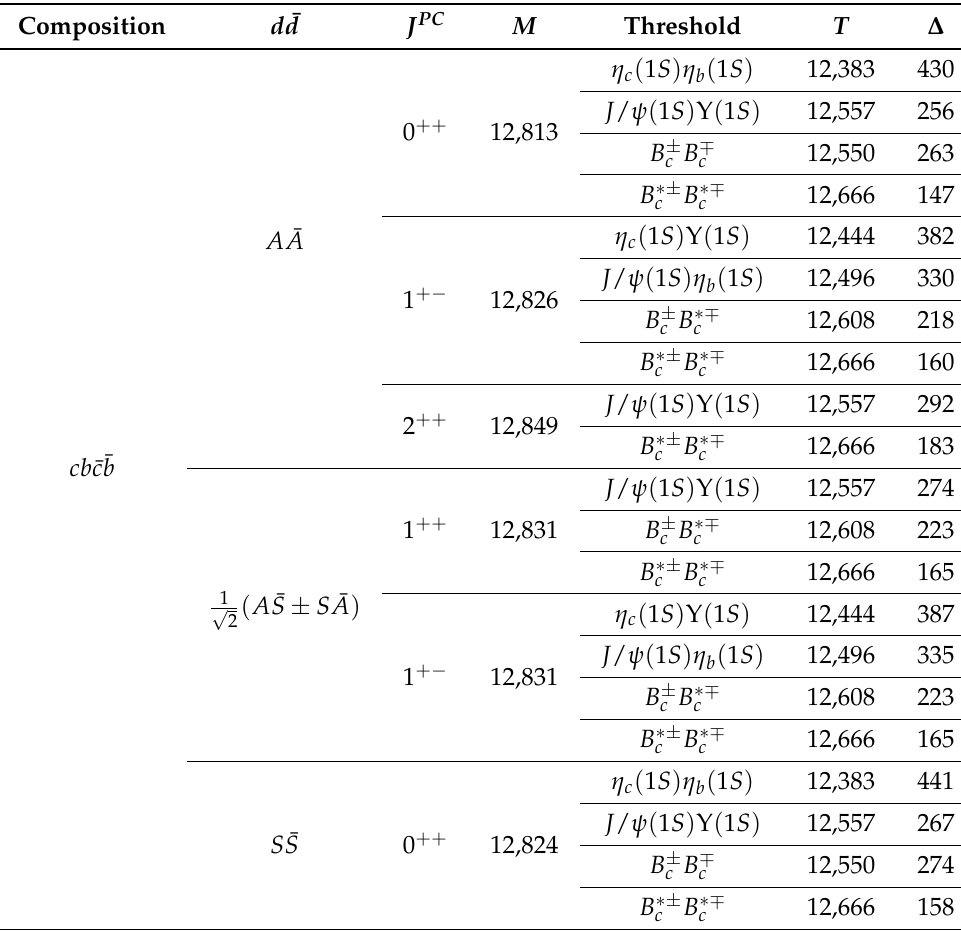
Table 10. Masses M of the neutral heavy diquark ( cb )-antidiquark (¯ c ¯ b ) states. T is the threshold for the decays into two heavy-( Q ¯ Q (cid:48) ) mesons and ∆ = M − T . All values are given in